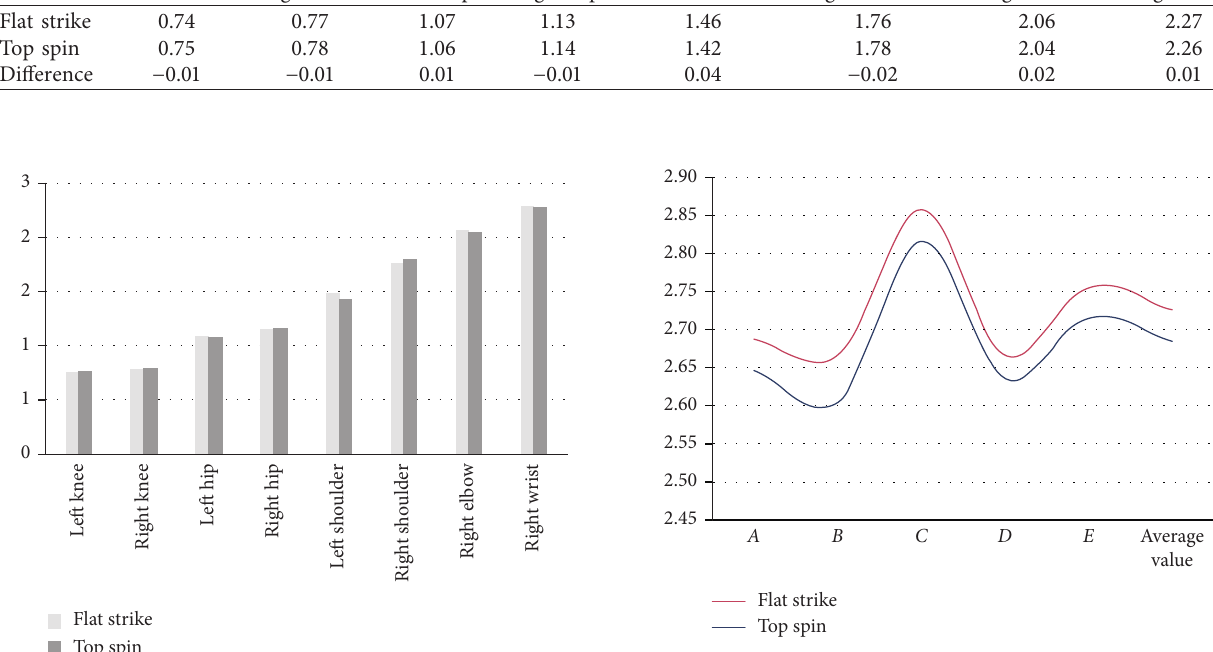
Figure 12: Comparison diagram of the height of the hitting point of the flat strike and the top spin (unit: m). Table 7: The three-dimensional distance between hitting point and head space position of the flat strike (unit: